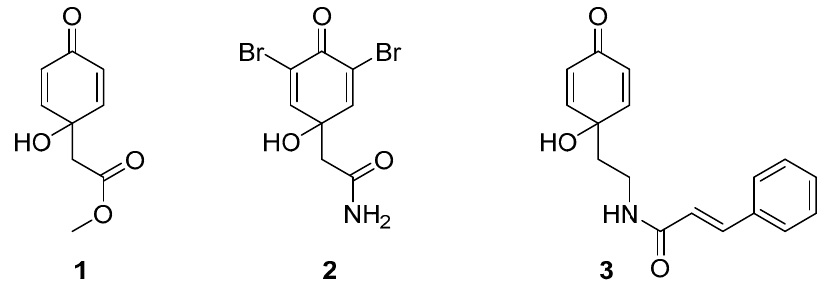
Figure 1. Naturally occurring quinols with remarkable biological activity.